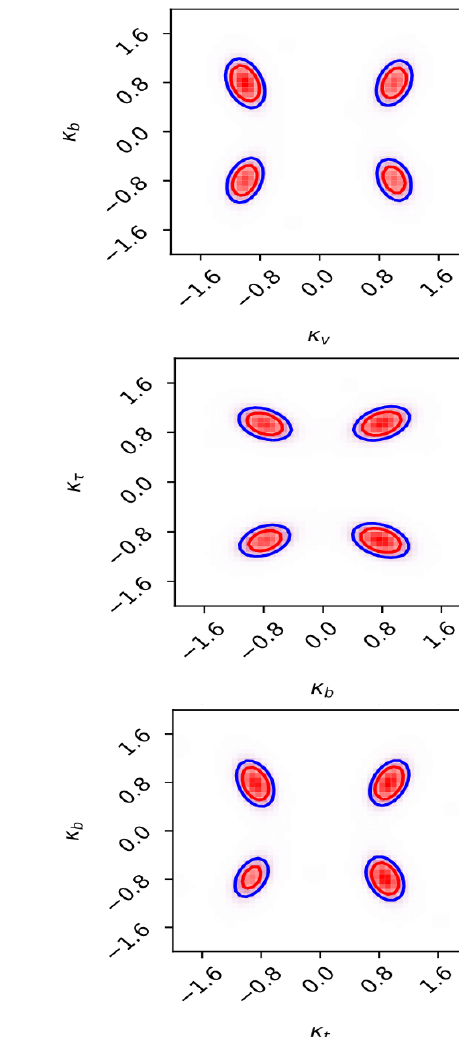
In (cid:12)gure 3 we show correlation between the (cid:20) ’s and the Wilson coe(cid:14)cients f f . f and f contribute to h ! Z(cid:13) but not h ! (cid:13)(cid:13) , since only the neutral component WW B W